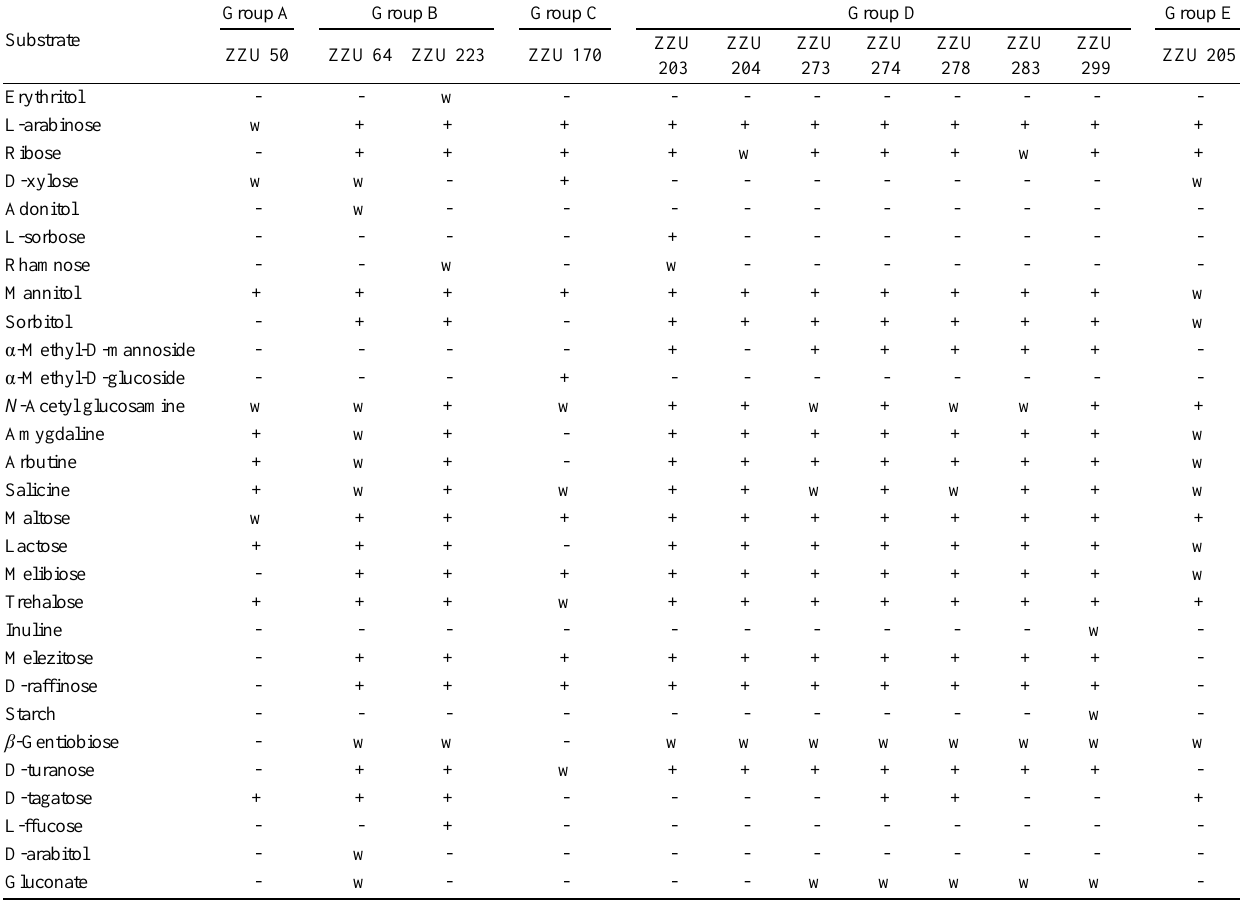
Table 3. API 50 CH fermentation patterns of latic acid bacteria